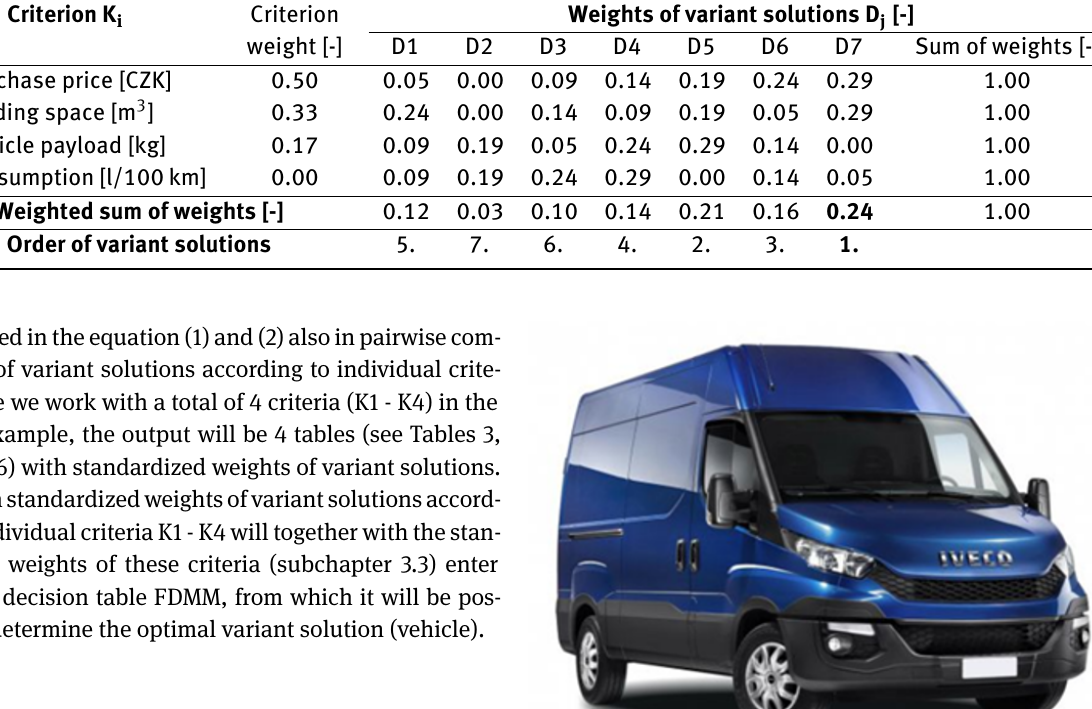
Table 7: Final decision table FDMM [author]. Criterion K i